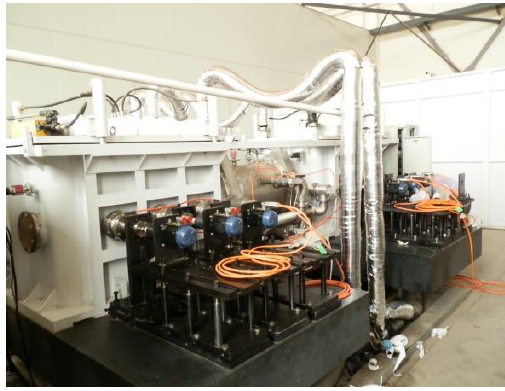
Figure 5. Test equipment.